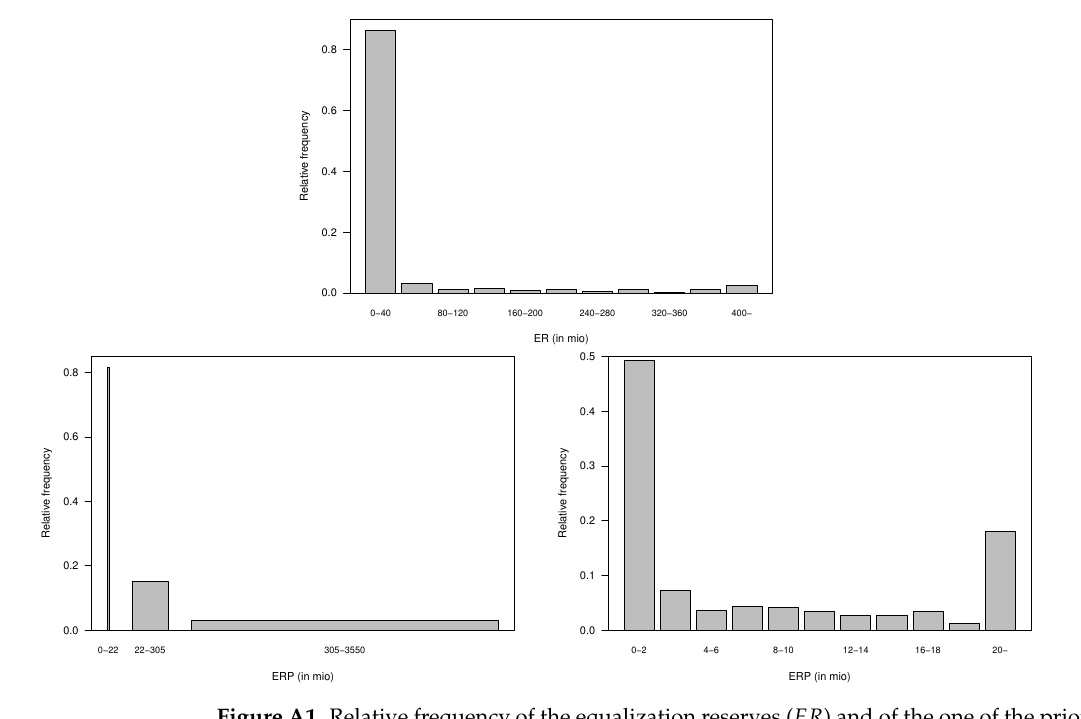
Figure A1. Relative frequency of the equalization reserves ( ER ) and of the one of the prior year ( ERP ) for reinsurance undertakings. The figure presents twice the relative frequency of ERP : once sliced by the optimal bin out of our model and once sliced by equal bands, whereby the last band includes all remaining higher observations.